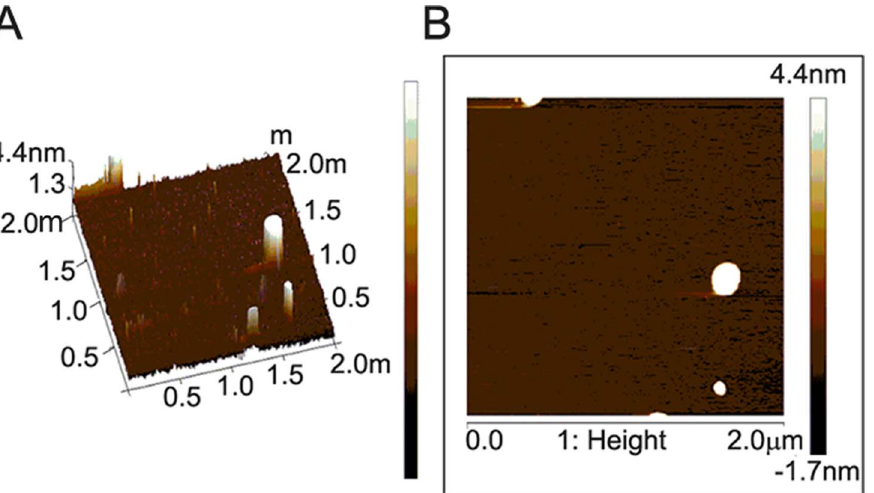
Figure 2. Atomic Force Microscopy micrographs of H 2 bdtc loaded in SLNs (A) 2 m m 6 2 m m three-dimensional image. (B) 2 m m 6 2 m m planar